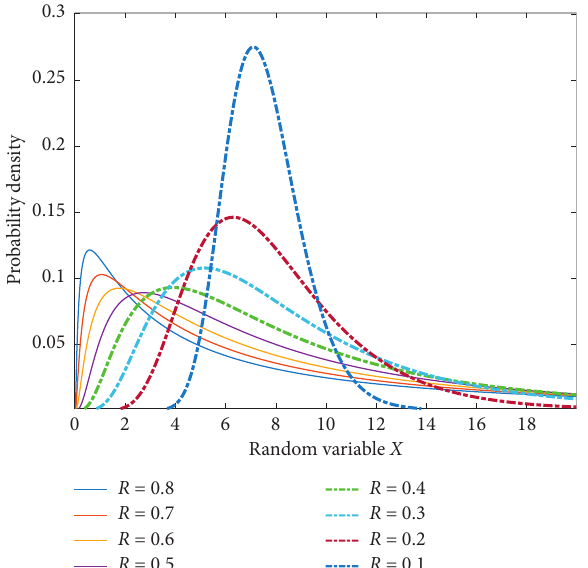
) is ranged from X / μ X